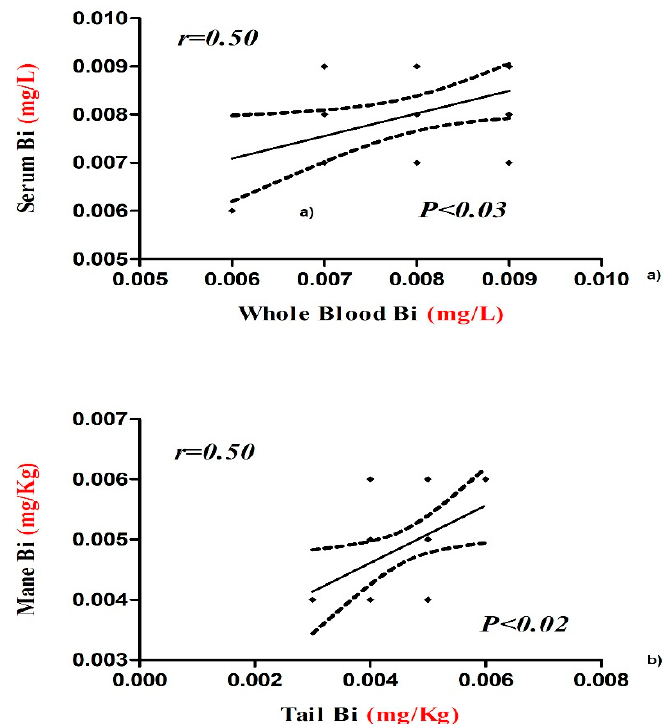
Figure 2. Positive correlation between whole blood and serum concentration ( a ) and mane and tail hair concentration ( b ) of Bi with Pearson’s correlation coefficients and significant values in horse.